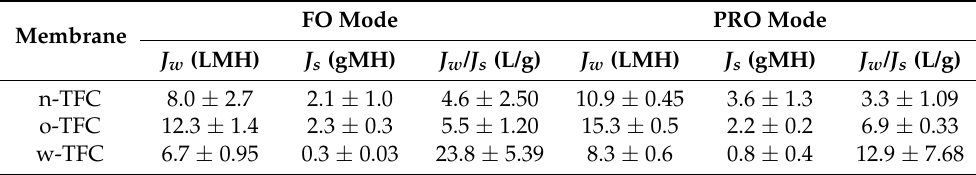
Figure 10. Water flux ( J w ) and reverse salt flux ( J s ) of the nanofiber-supported TFC FO membranes prepared with different heat-curing methods: ( a ) FO mode; ( b ) PRO mode; ( c ) calculated specific water flux ( J w / J s , L/g) under two modes. ( d ) Comparison of water flux changes of the nanofiber TFC FO membranes via hot-water-curing and oven-curing over time under FO mode (Feed solution: DI water; Draw solution: 3.5 wt % NaCl). Table 5. Atomic compositions of nanofiber-supported PA layers prepared via different heat-curing methods.